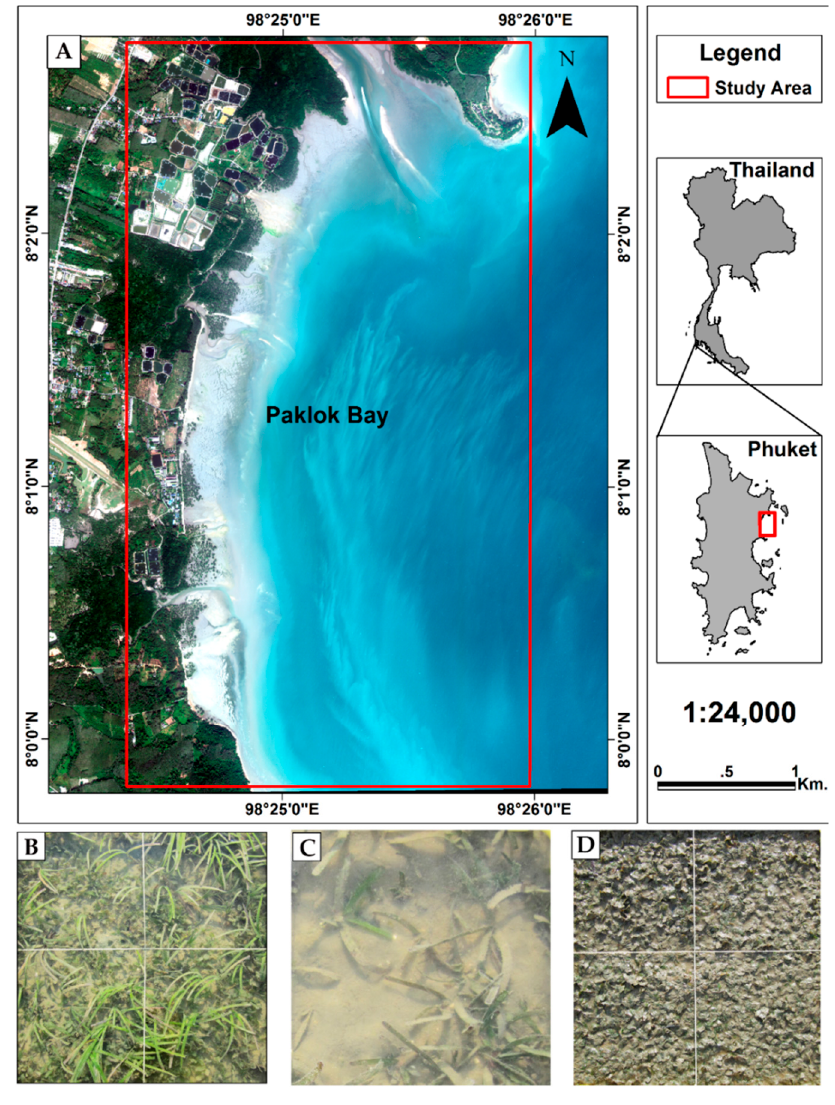
Figure 1. ( A ) The satellite image of Paklok Bay captured by WV-2 sensor on 27 December 2013. The top left of the area shows the several shrimp farms along the shore that were sources of turbid waters; ( B ) Mixed dense seagrass; ( C ) sparse seagrass ( Thalassia hemiprichii ) with turbid waters; and ( D ) seagrass ( Halophila ovalis ) coated with silt-clay caused from the rivers discharge turbid waters.